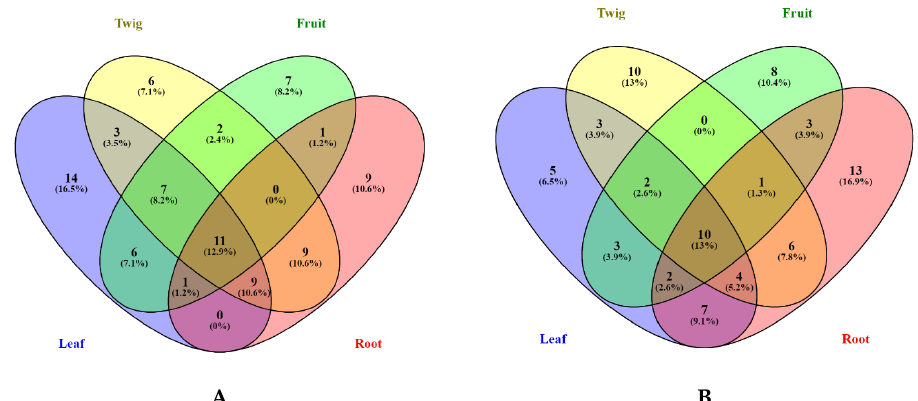
Figure 1. Venn diagrams showing number of compounds identified from methanolic ( A ) and ethyl acetate ( B ) extracts.